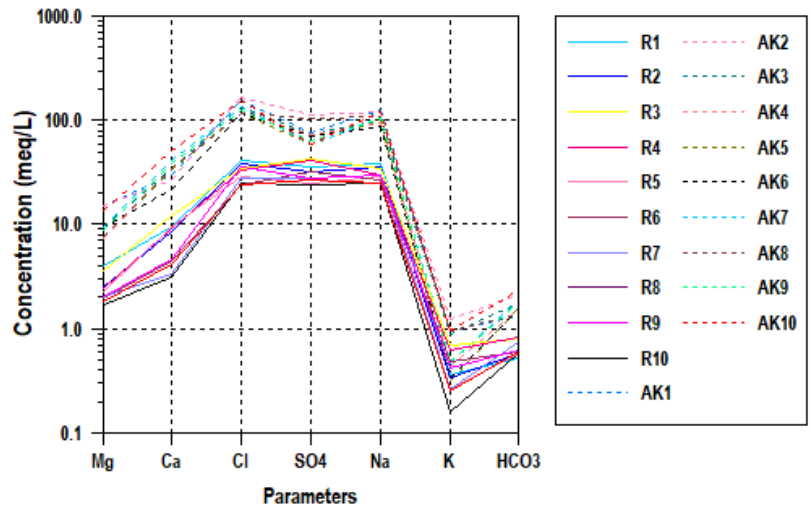
Figure 13. Schoeller plot of the collected groundwater samples at Al Khatim (AK) and Remah (R).